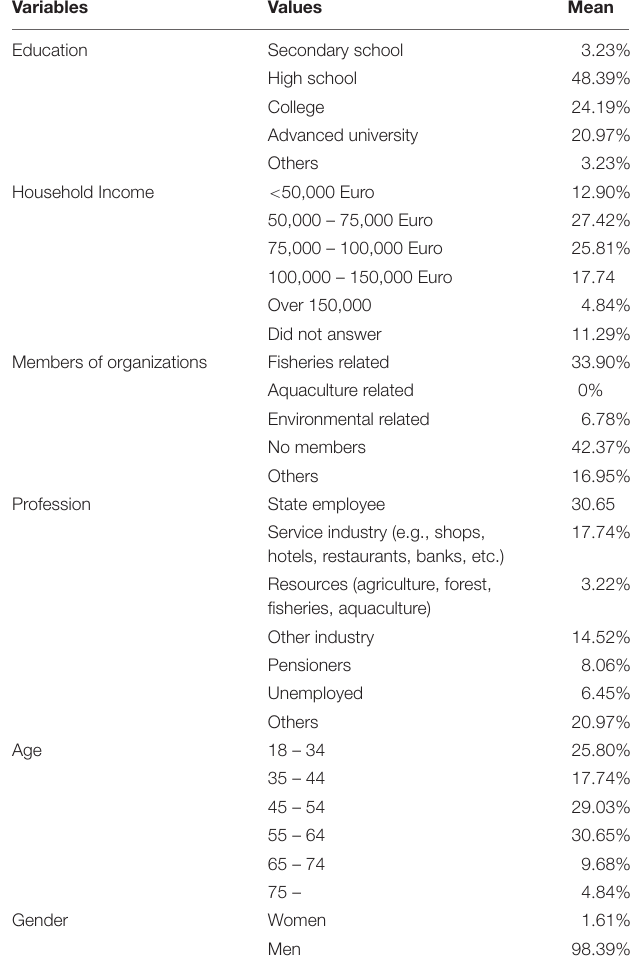
TABLE 1 | Summary of social-demographic information of